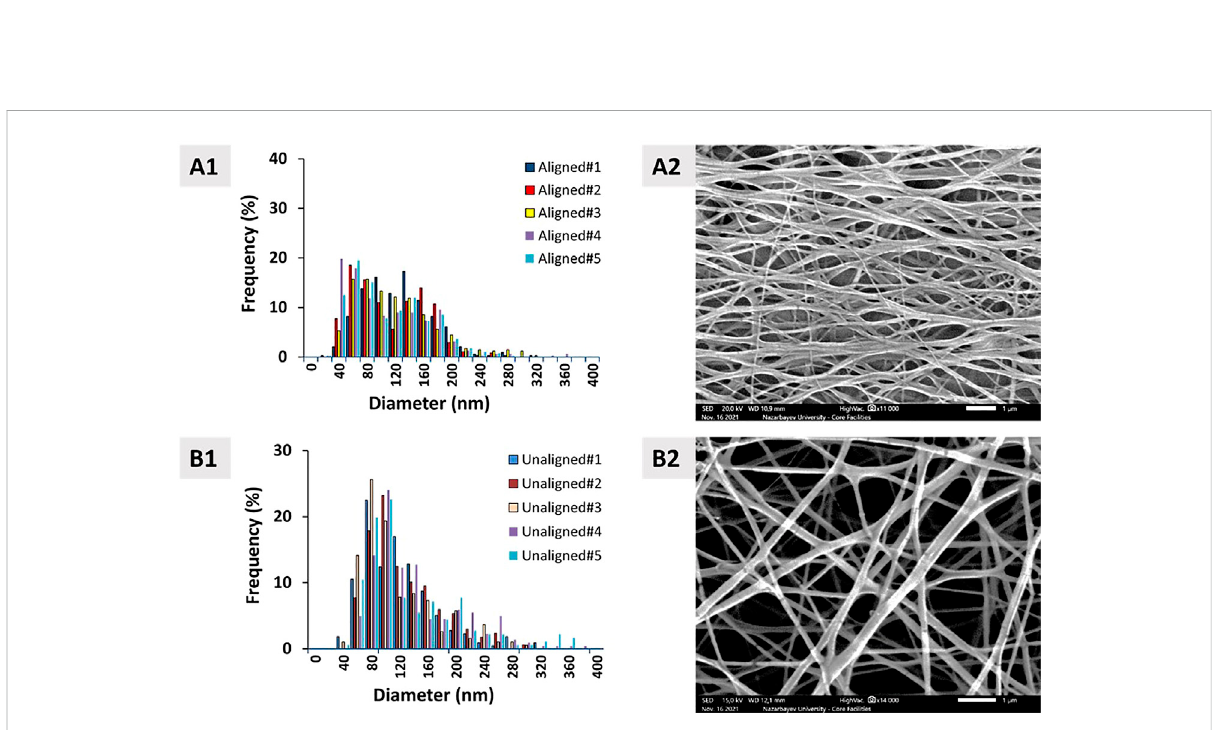
FIGURE 4 Diameter distribution of (A1) aligned and (B1) unaligned PCL fi bers and corresponding representative SEM images ( (A2, B2) , n = 5). Scale bar = 1 μ m.